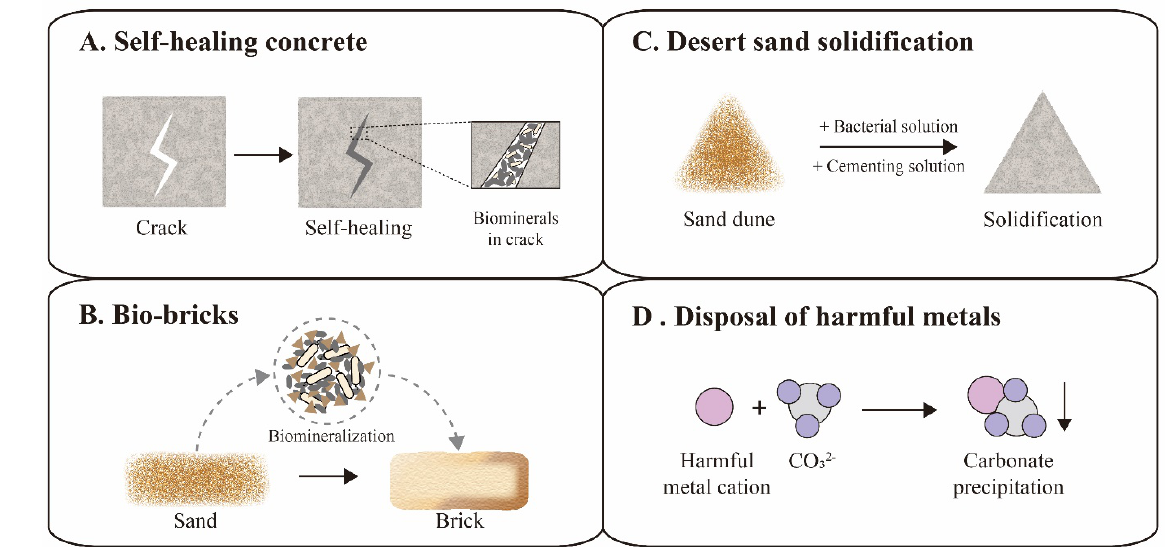
Figure 4. Applications of ureolytic biomineralization. Self-healing concrete ( A ) and bio-bricks ( B ) are representative cases in the construction field. Desert sand solidification ( C ) and disposal of harmful metals ( D ) are representative cases in the environmental protection field.